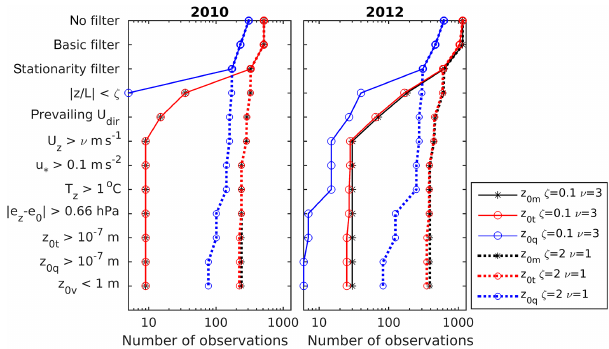
Figure 2. Initial number of observations for estimating the rough- ness lengths (from 30min averages of OPEC data) and remaining number of observations after each filter is applied (ordered from top down) for 2010 and 2012 observational periods. Solid line repre- sents the filters used to determine the roughness lengths, and dotted line represents the filters used to determine the fluxes of momentum, temperature, and